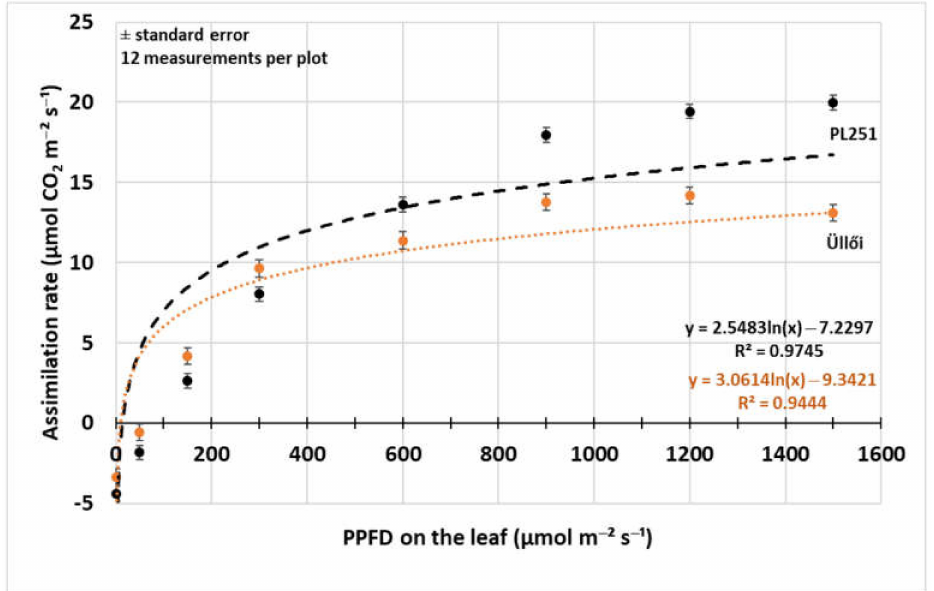
Figure 4. Photosynthesis rate light response curve of black locust clone ‘PL251’ and variety ‘Üll˝oi’ (29 May 2021); ± standard